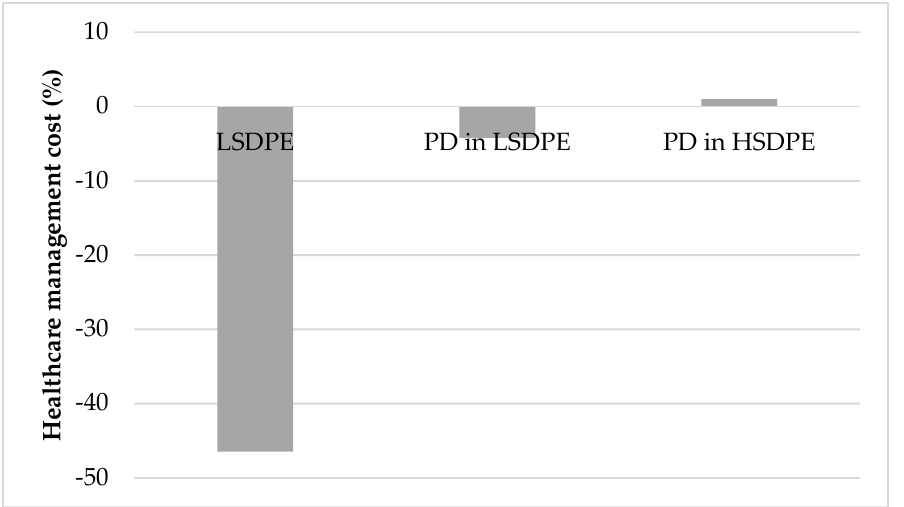
Figure 3. Mean percentage differences in healthcare management cost per animal per year in positive deviants (PD) and typical farms under low-stress (LSDPE) and high-stress (HSDPE) environments.